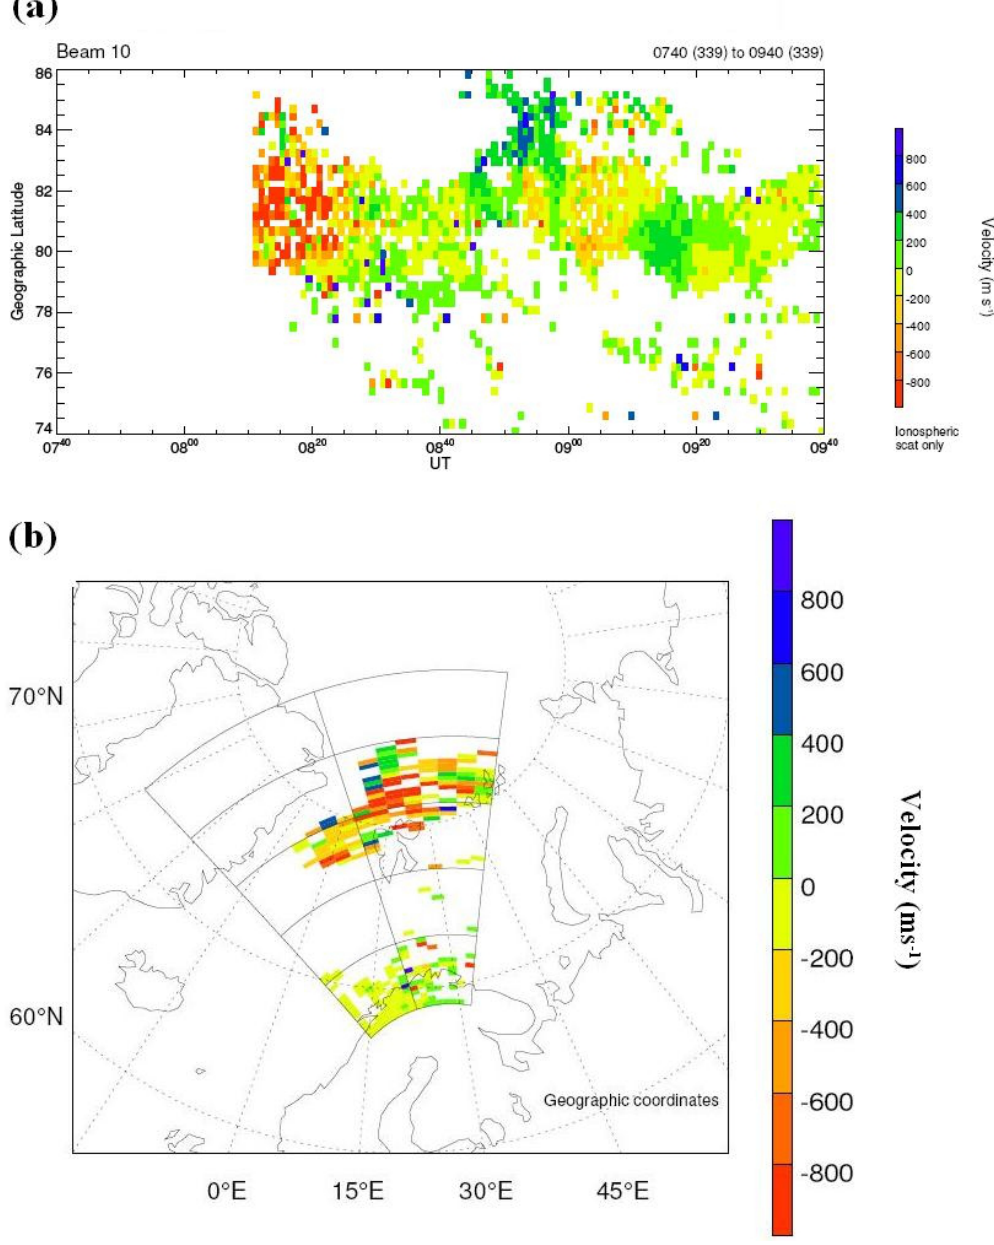
Fig. 8. CUTLASS radar ion velocities from 5 December 2007 demonstrating (a) the short duration of the burst of flow, and (b) the spatially localised focus to the NNW of Svalbard at 0815 UT.